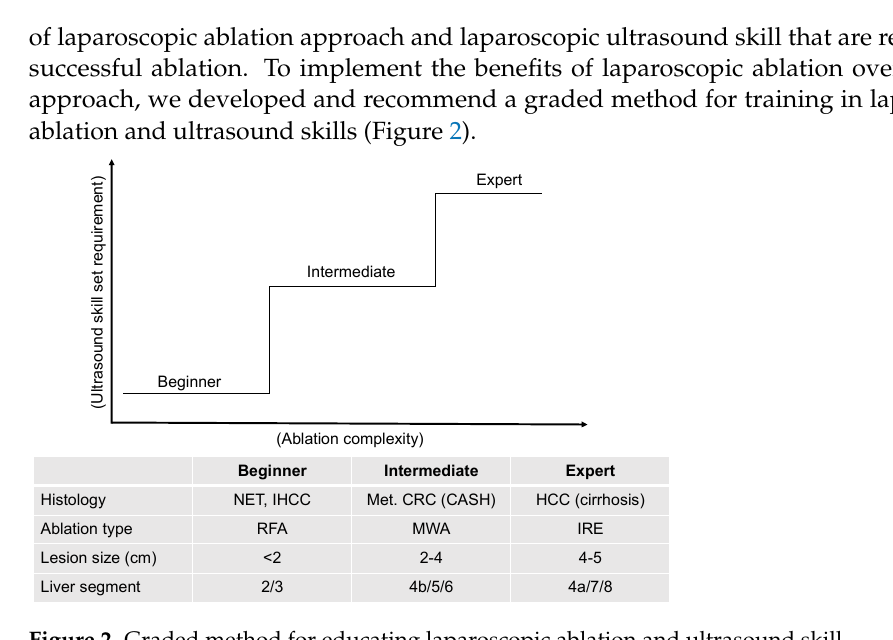
Figure 2. Graded method for educating laparoscopic ablation and ultrasound skill.